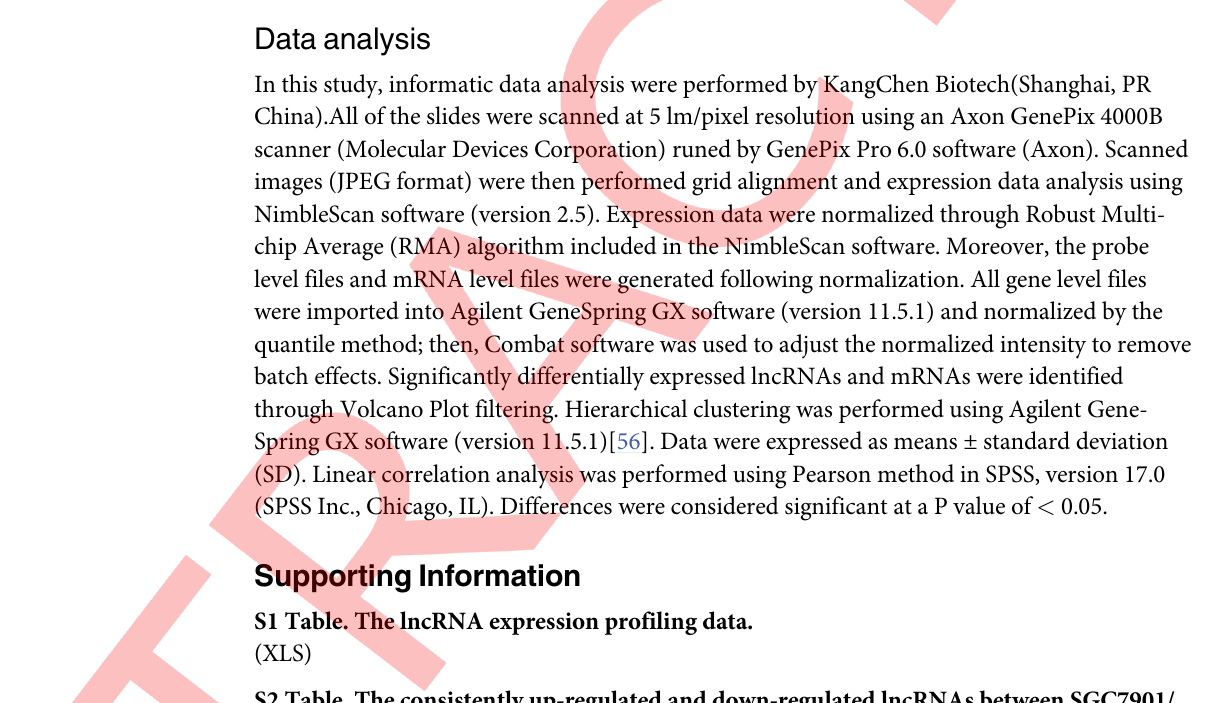
S3 Table. The mRNA expression profiling data.